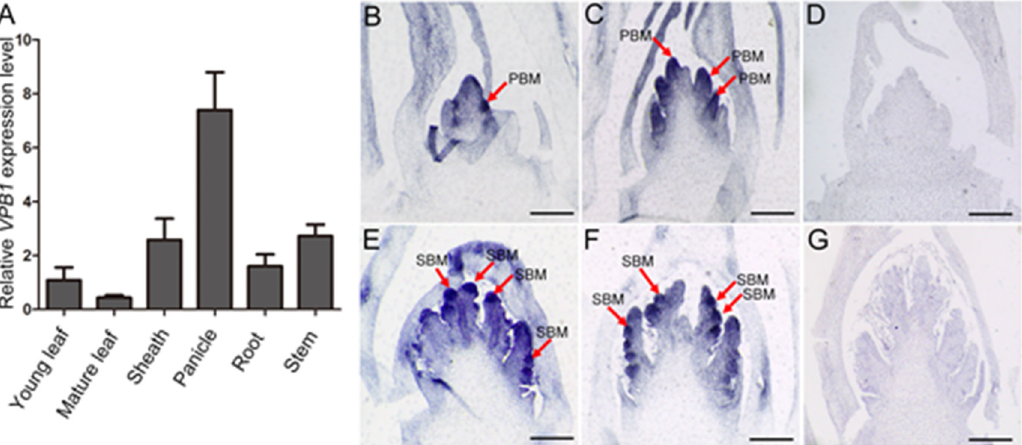
Figure 4. Expression pattern of VPB1 . ( A ) RT–qPCR of organ-specific VPB1 expression in WT plants. Including young leaf, mature leaf, sheath, panicle (1–2 mm), root, stem. Data are mean ± SD (n=3 biological replicates). ( B – G ) In situ hybridization of VPB1 . ( B ) Whole a developing inflorescence at the stage of SAM; ( C ) Whole a developing inflorescence at the stage of primary branch meristem (PBM) differentiation; ( E , F ) Whole a developing inflorescence at the stage of secondary branch meristem (SBM) differentiation. ( D , G ) Sense probe as control. The red arrow points to the branch meristem. Scale bars, 100 µ m.